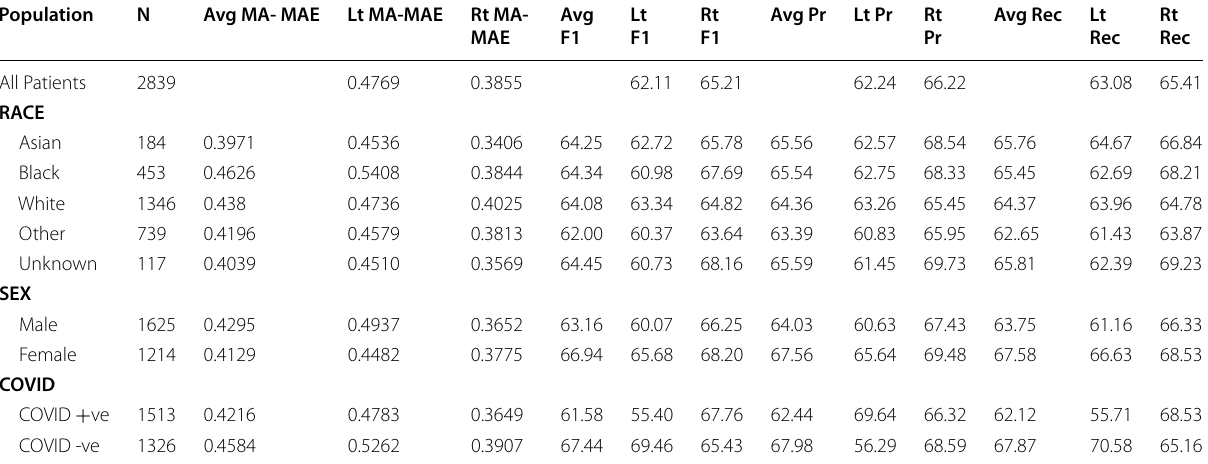
Table 8 Performance analysis of best